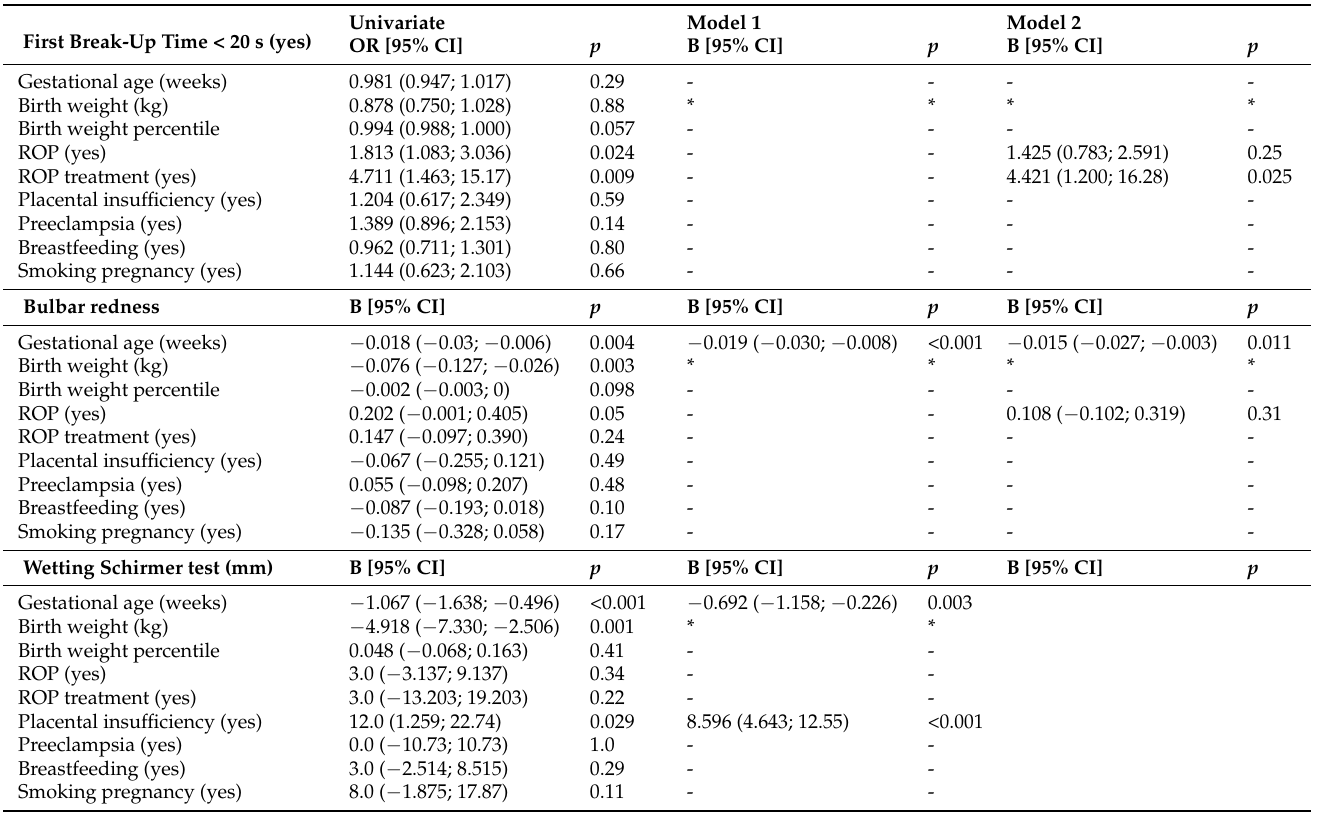
Table 4. Linear associations of anterior segment parameters with different perinatal parameters for the sample of the Gutenberg Prematurity Eye